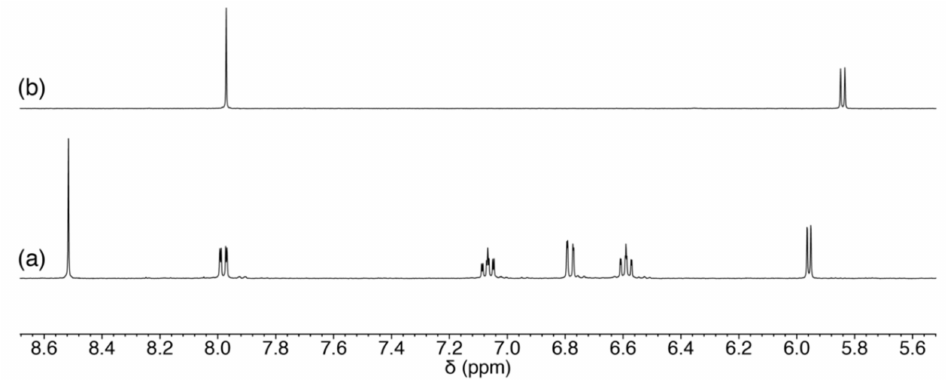
Figure 12. 1 H NMR spectra of ( a ) the reaction mixture of 1 and guanosine, and ( b ) guanosine in CD 3